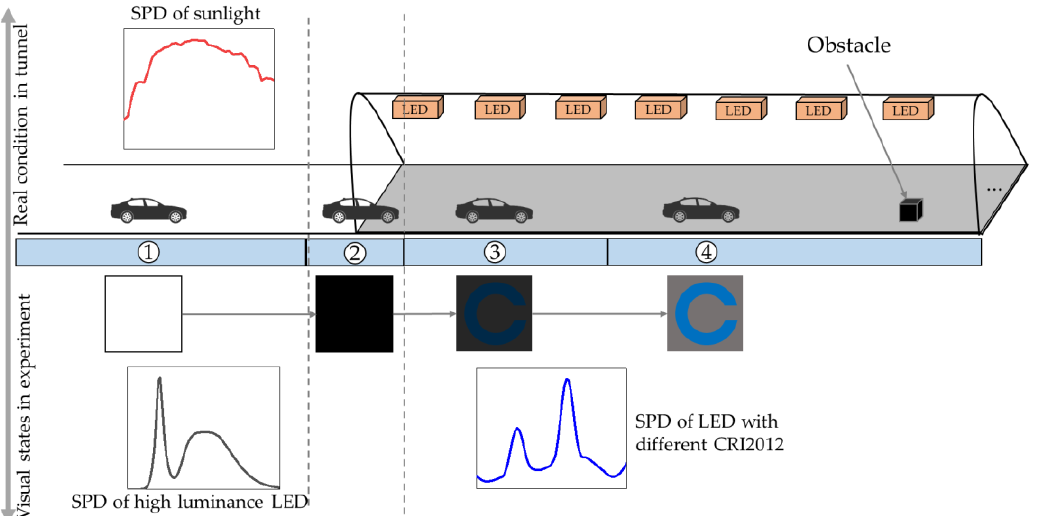
Figure 9. The driving condition of the actual tunnel entrance and the visual states of the subjects in the experiment. SPD = spectral power distribution; LED = light-emitting diode; CRI2012 refers to a color difference-based color rendering index.